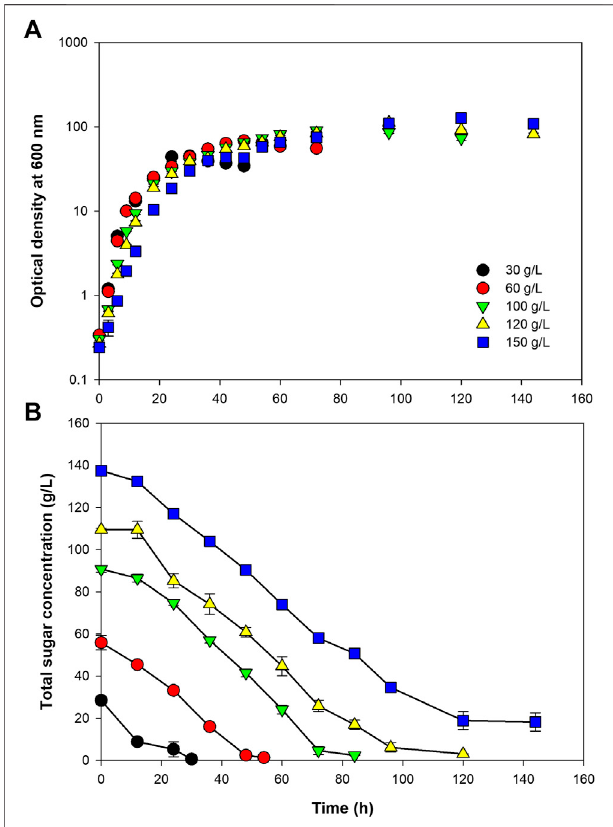
FIGURE 2 | Growth of Paracoccus sp. KKU01 on sugarcane juice- based medium (A) and total sugar consumption (B) at initial total sugar concentration of 30 – 150